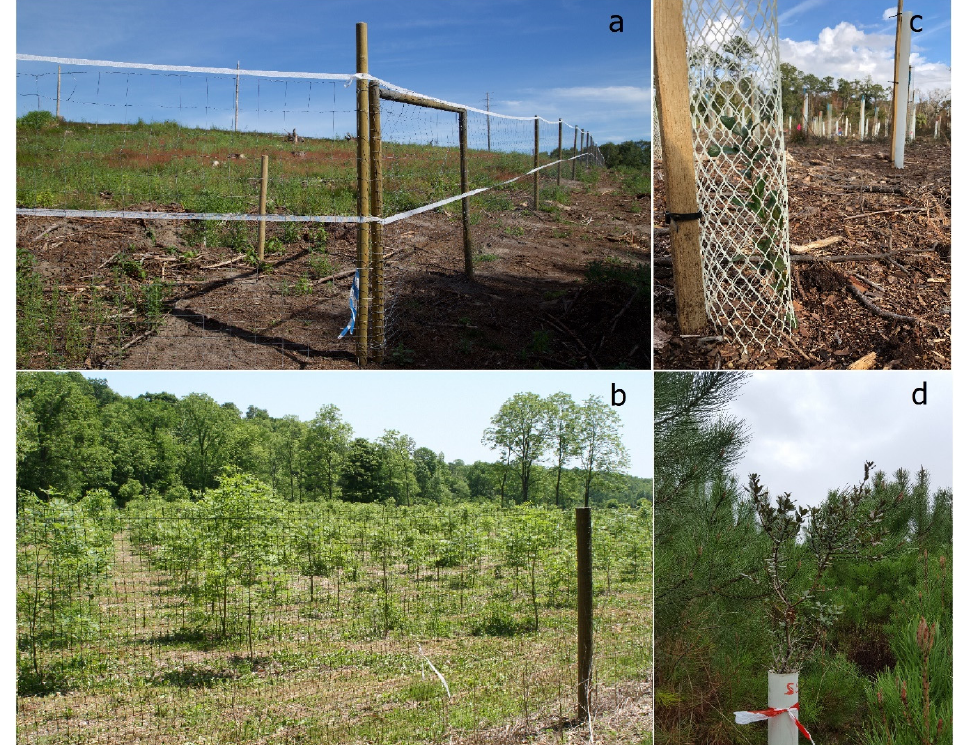
Figure 1. Illustrations of some of the browse management methods commonly encountered in the literature: Wire fencing with Quercus robur in southern Sweden ( a ), plastic mesh fencing for Juglans nigra in Indiana, USA ( b ), mesh sleeves on Quercus virginiana in coastal Georgia, USA ( c ), and solid-walled tree shelters on planted Querus ilex combined with plant facilitation from Pinus pinaster natural regeneration on the northern coast of Tuscany, Italy ( d ). Photo credits: D.F. Jacobs ( a – c ) and B. Mariotti ( d